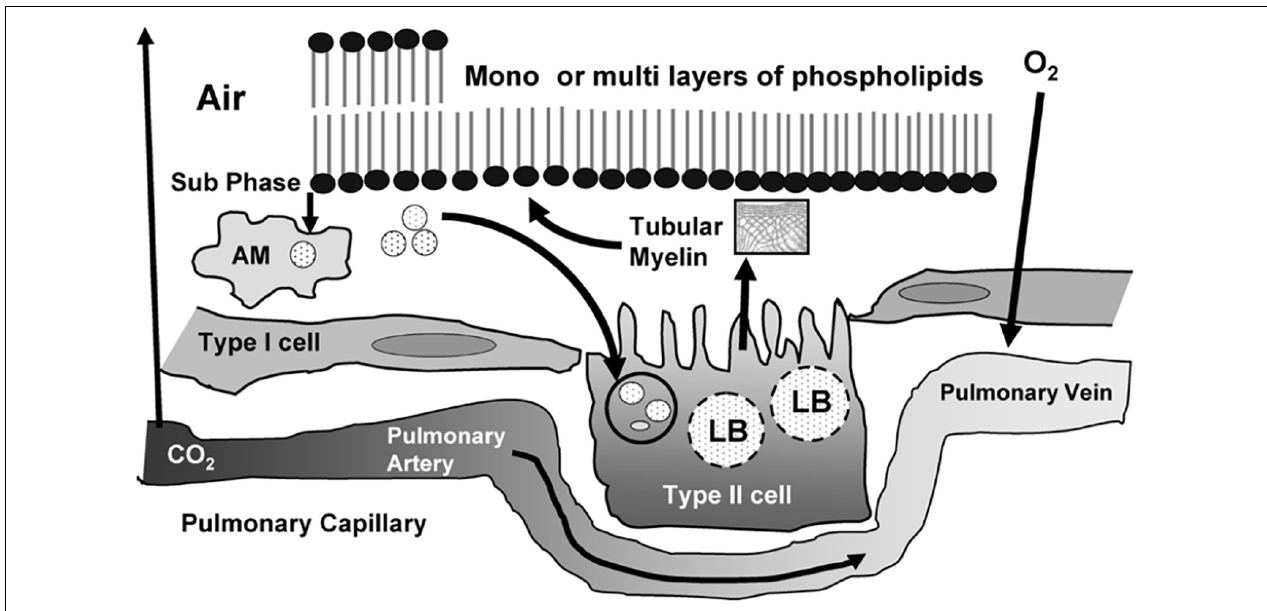
FIGURE 10 | Life cycle of surfactant produced in the lung with an indication of the tubular myelin, lamellar bodies (LB), and alveolar macrophages (AM). Pulmonary surfactant is a surface-active lipo-protein complex produced by type II alveolar cells. Reprinted from Ramanathan (2006) with permission.